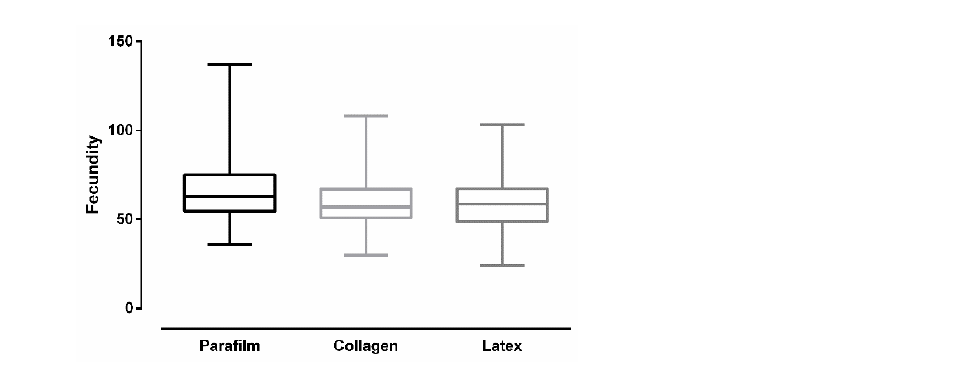
Figure 3. Fecundity of Aedes aegypti females after artificial blood feeding on different membranes (bars = ± SEM).